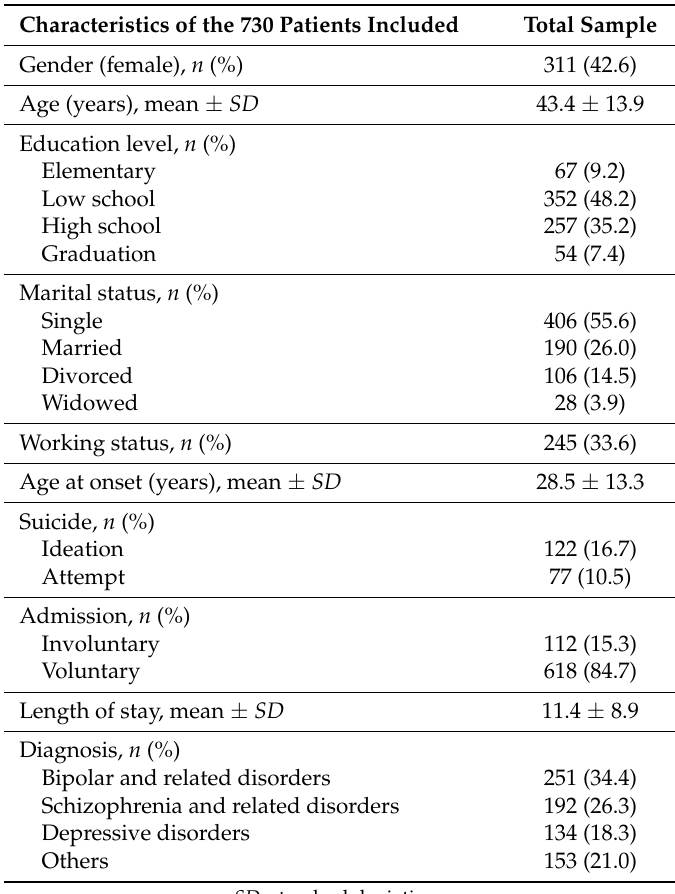
Table 1. Socio-demographic and clinical characteristics in the total sample ( n =